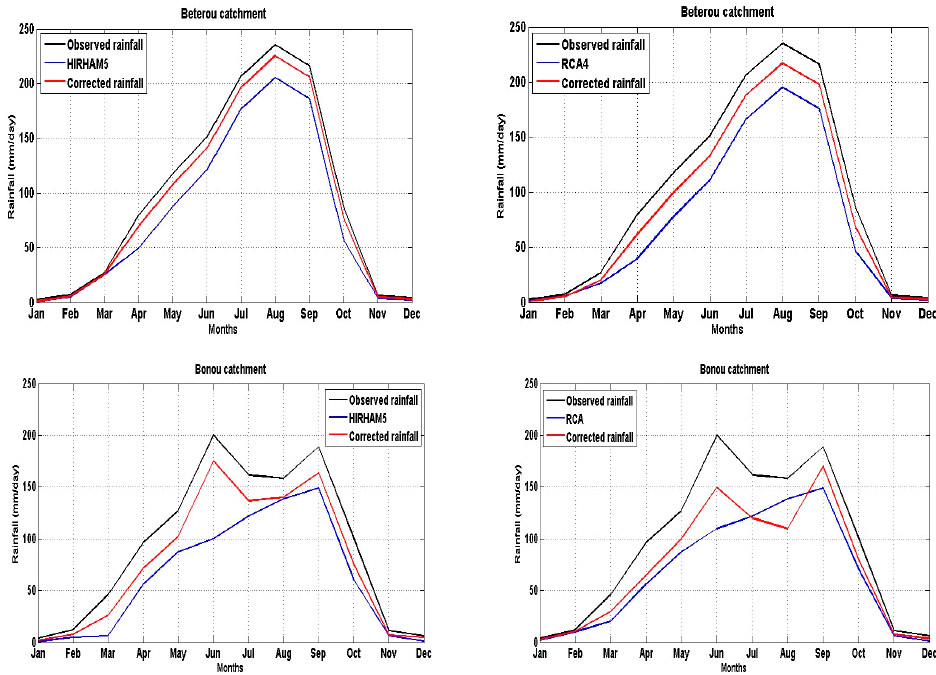
Figure 5. Seasonal cycle of raw and corrected RCM over the period 1961–1990 in Bétérou ( top ): HIRHAM5 rainfall ( left ), RCA4 rainfall ( right ) and Bonou ( bottom ): HIRHAM5 rainfall ( left ), RCA4 rainfall ( right ) catchments.